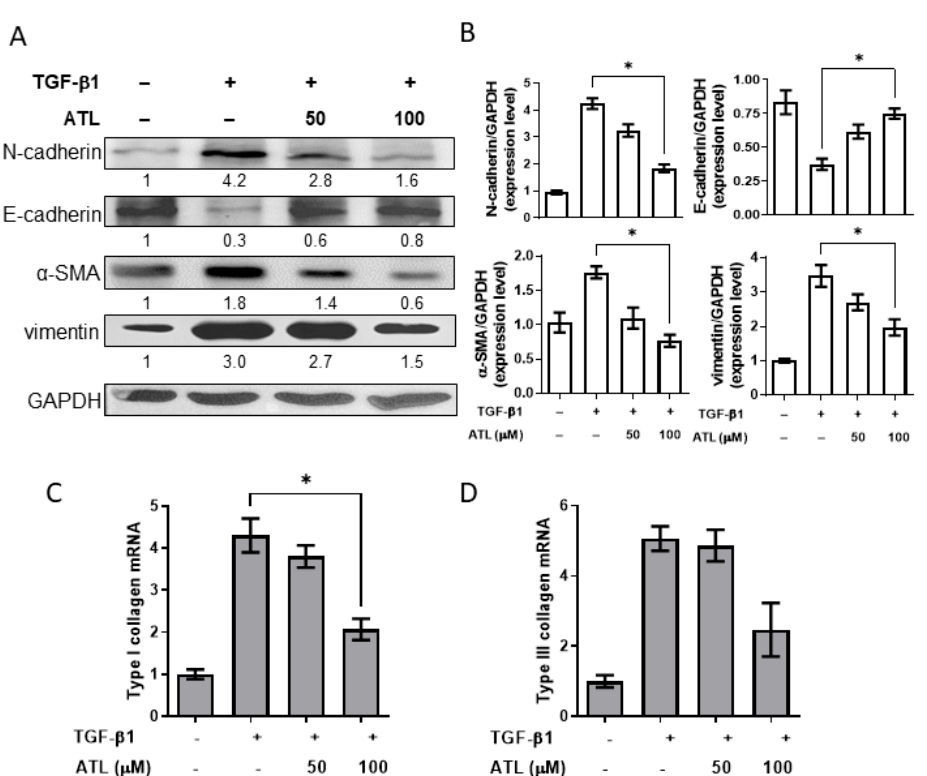
Figure 2. Effect of atractylodin stymied on TGF- β 1-induced EMT-associated protein expressions in A549 cells. A549 cells were pretreated with ATL for 1 h followed by TGF- β 1 (2 ng/mL) stimulation for an additional 24 h. Cells treated with DMSO were set up as the control groups. ( A ) Protein expression levels of N-cadherin, E-cadherin, α -SMA, and vimentin were measured by Western blot assay. ( B ) Quantitation of Western blot signal intensities by ImageJ software. ( C ) The transcriptional expressions of type I collagen and ( D ) type III collagen were conducted by RT-qPCR. Values represent the mean ± SEM from triplicate samples for each treatment. (*) p < 0.05 versus TGF- β 1 + 0.1% DMSO-treated control, as determined by non-parametric Kruskal–Wallis test and all pairwise multiple comparison procedures (Dunn’s Method).